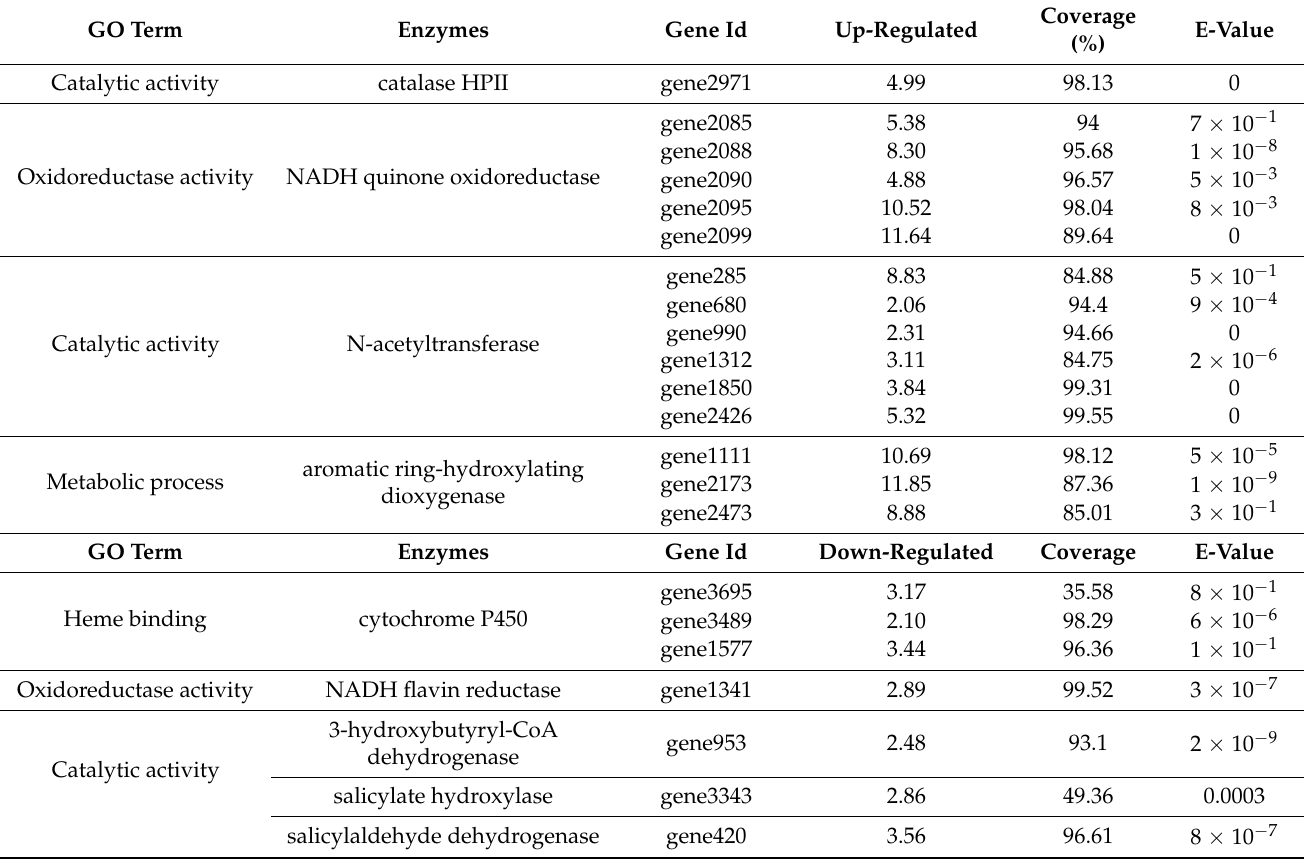
Table 3. Clustering of DEGs and their gene expression